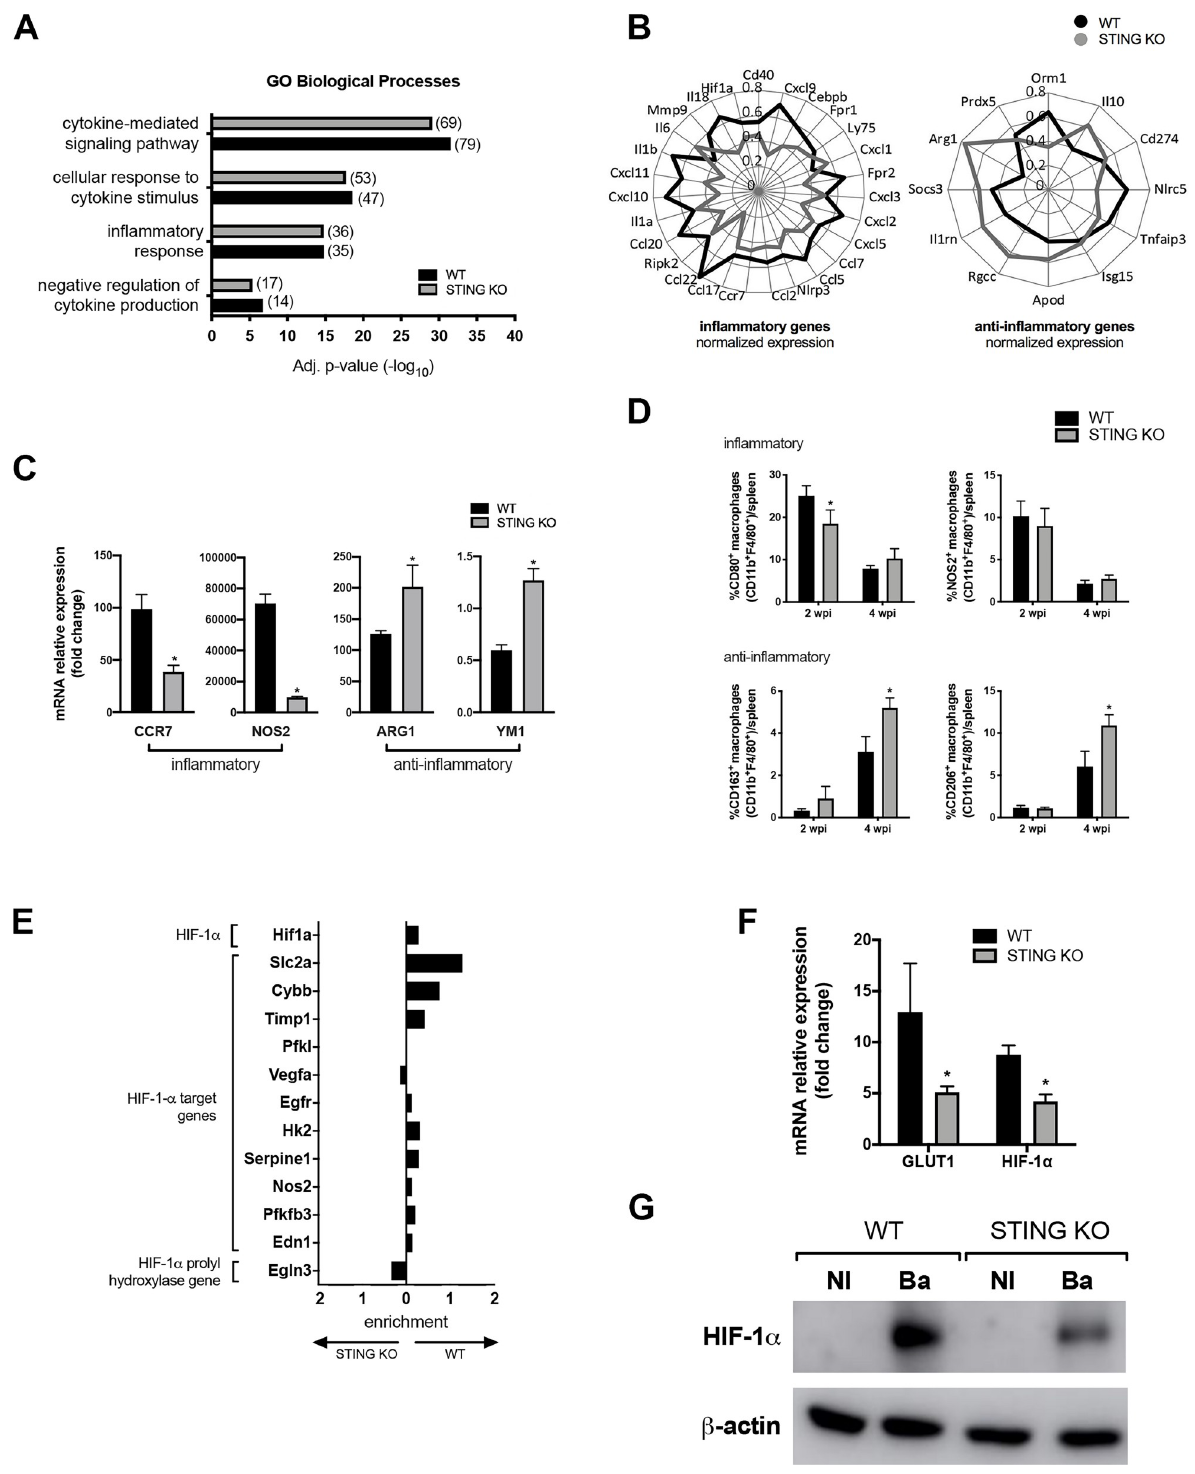
Fig 1. STING contributes to an inflammatory profile in macrophages infected with B . abortus . (A) Gene ontology enrichment analysis of differentially expressed genes from infected C57BL/6 (WT) or STING KO macrophages. The number of genes related to enriched GO biological process is indicated in each case. (B) Fold change of inflammatory and anti-inflammatory genes upregulated in infected C57BL/6 (WT) or STING KO macrophages. The numbers in radial axes represent the value obtained after the normalization between genotypes of the fold change observed for each gene. (C) CCR7, NOS2, ARG1, and YM1 expression levels determined by real-time RT-PCR in B . abortus -infected macrophages derived